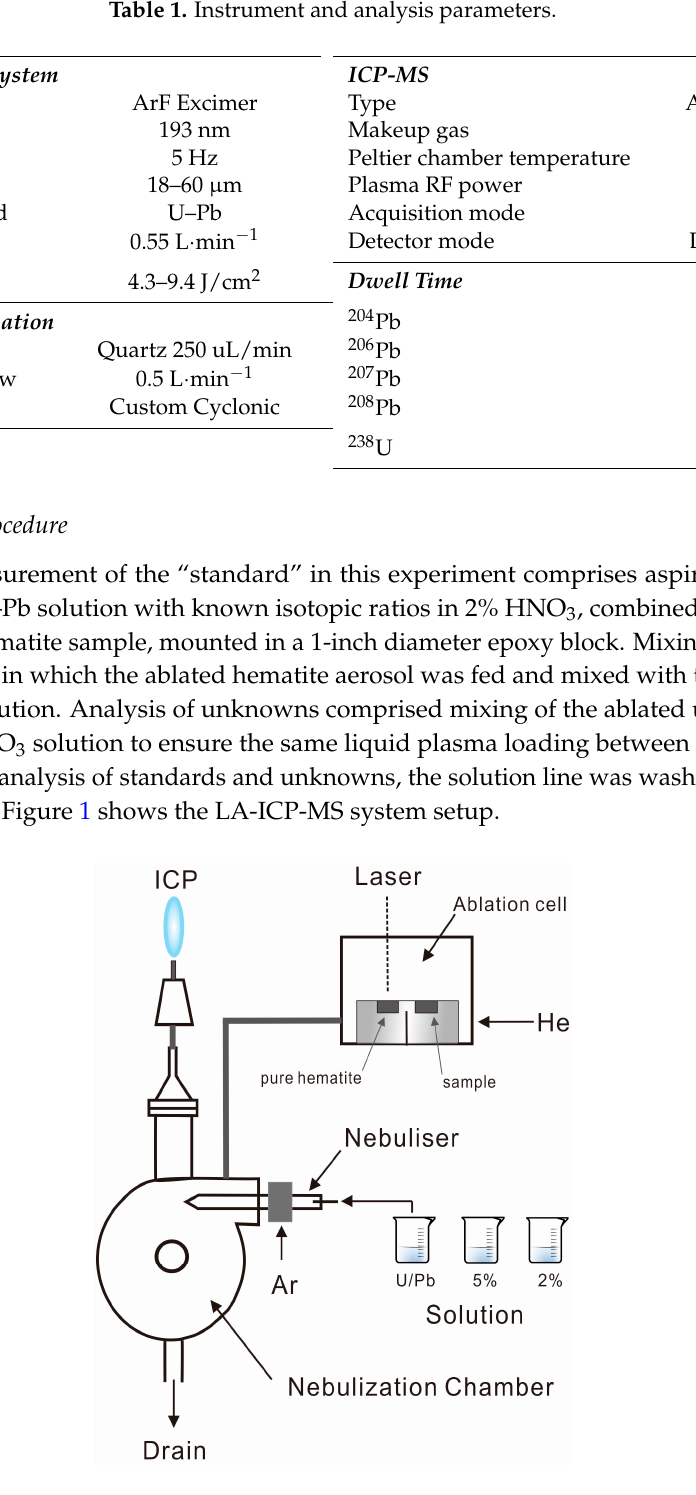
Table 1. Instrument and analysis parameters.